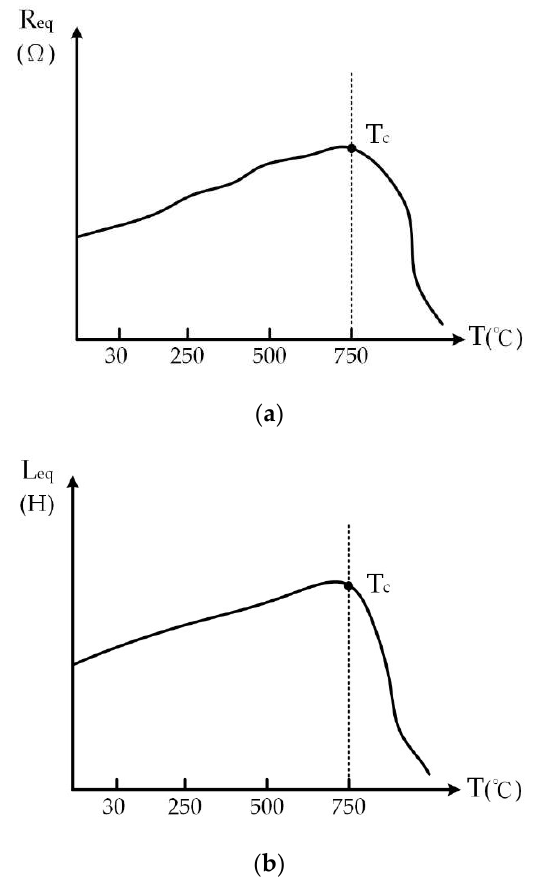
Figure 5. Schematic diagram of the trend: ( a ) variation in equivalent resistance with temperature, ( b ) variation in equivalent inductance with temperature.